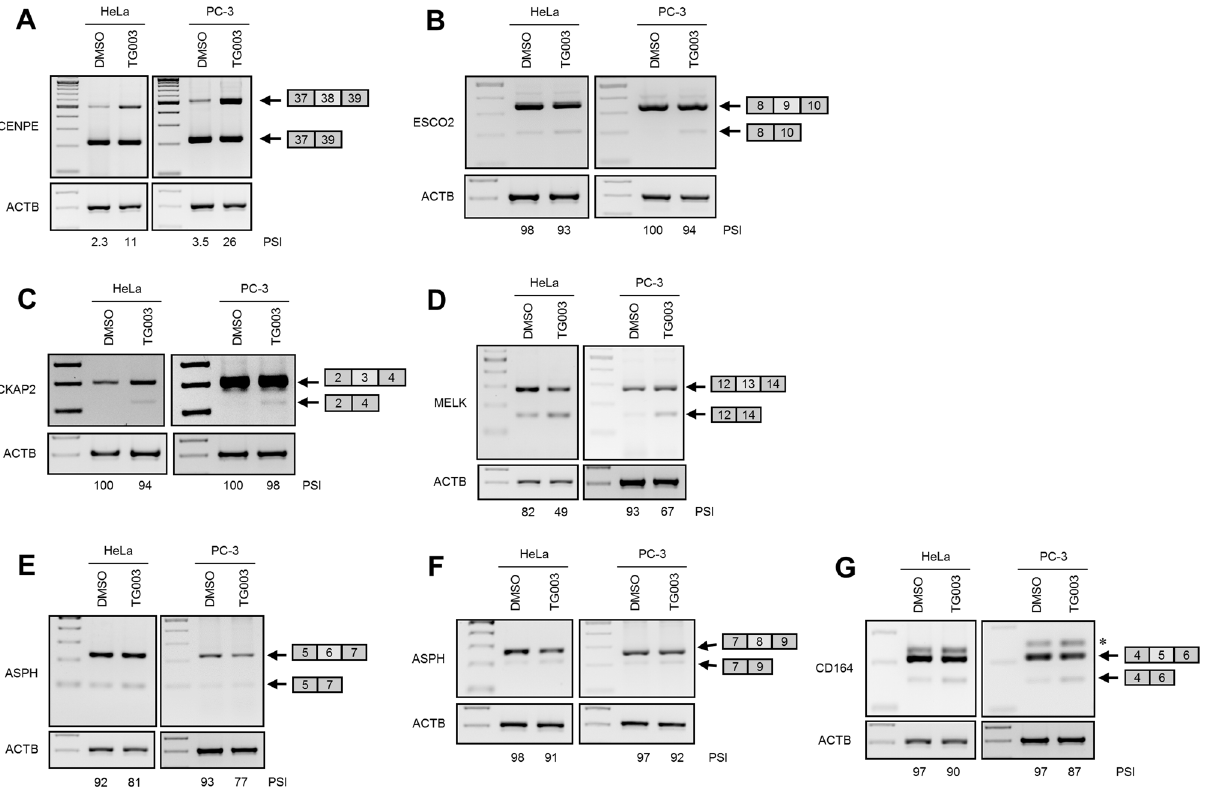
Figure 7. RT-PCR validation for RNA-Seq analysis in HeLa and PC-3 cells. RT-PCR results for ( A ) centromere protein E (CENPE) exon 38; ( B ) establishment of sister chromatid cohesion N-acetyltransferase 2 (ESCO2) exon 9; ( C ) cytoskeleton associated protein 2 (CKAP2) exon 3; ( D ) maternal embryonic leucine zipper kinase (MELK) exon 13; ( E ) aspartate beta-hydroxylase (ASPH) exon 6 and ( F ) exon 8; and ( G ) CD164 exon 5. β-actin (ACTB) served as a loading. PSI, percent spliced-in. *, a stable hybrid of two splice products (exon 5 inclusion and skipping products) was confirmed by TA-cloning in ( G) CLK inhibitor TG003 potently inhibits prostate cancer cell growth in vitro and in vivo . TG003 reduces cell pro- liferation, increases apoptosis, reverses EMT marker expression and reduces cell invasion. Further research is now needed to develop clinically viable CLK inhibitors.